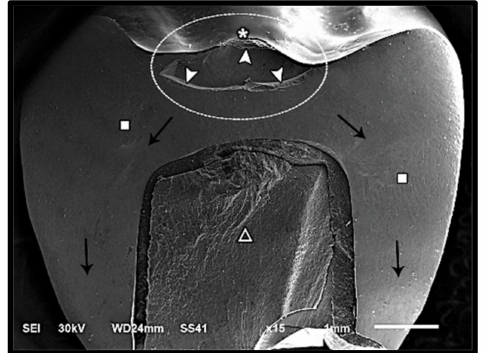
Figure 6. SEM micrograph represents class IV failure mode of lithium disilicate fractured specimen showing fracture origin (asterisk) at the loading occlusal surface of the restoration, hackle lines (square) indicating the direction of crack propagation (black arrow), arrest line (arrow-head) rep- resenting the limits of a small internal chip (dotted circle), and fracture of the restoration/tooth complex (triangle).